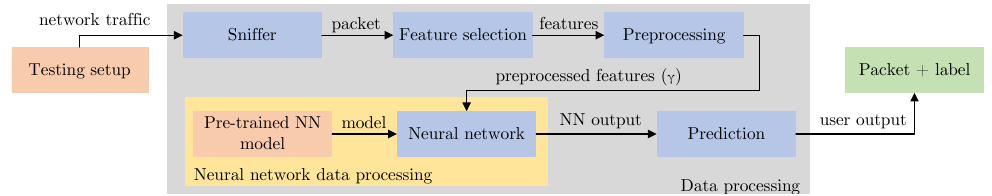
Figure 8. Implementation of our model in the